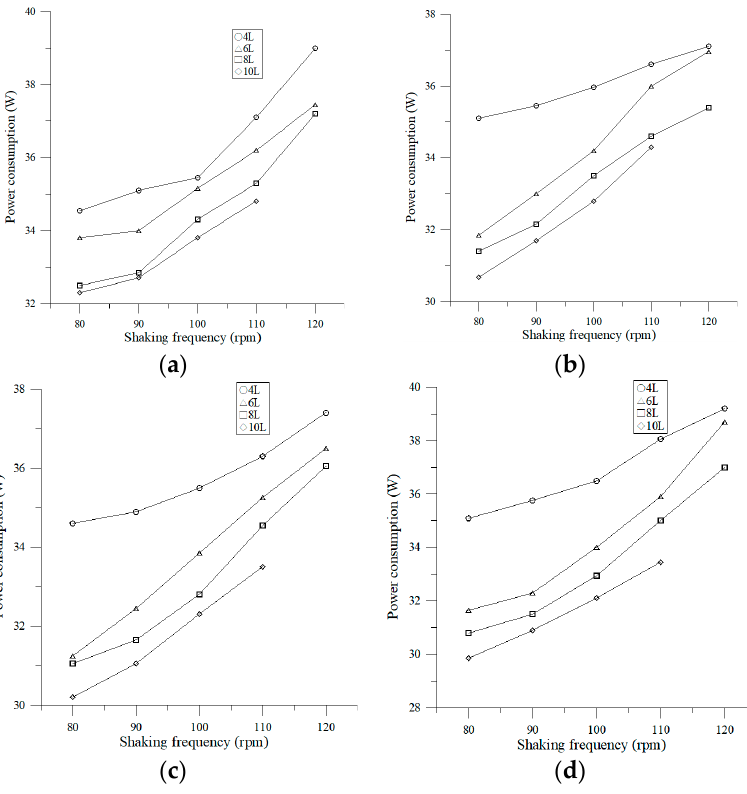
Figure 2. E ff ects of di ff erent filling volumes on local power consumption. ( a ) Water; ( b ) 5 vol% glycerin; Figure 2. Effects of different filling volumes on local power consumption. ( a ) Water; ( b ) 5 vol% ( c ) 10 vol% glycerin; ( d ) 20 vol% glycerin; ( c ) 10 vol% glycerin; ( d ) 20 vol% glycerin.